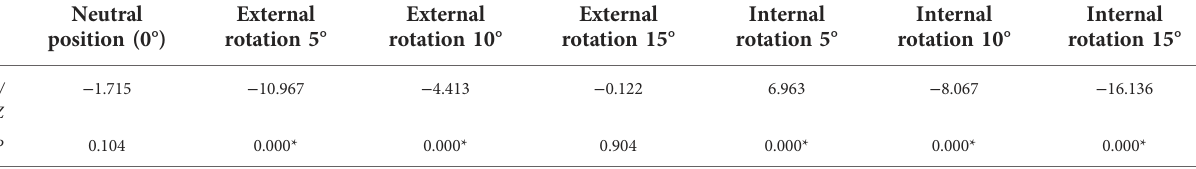
TABLE 3 Comparison of contact stresses between medial and lateral femoral – tibial side under 200 N.